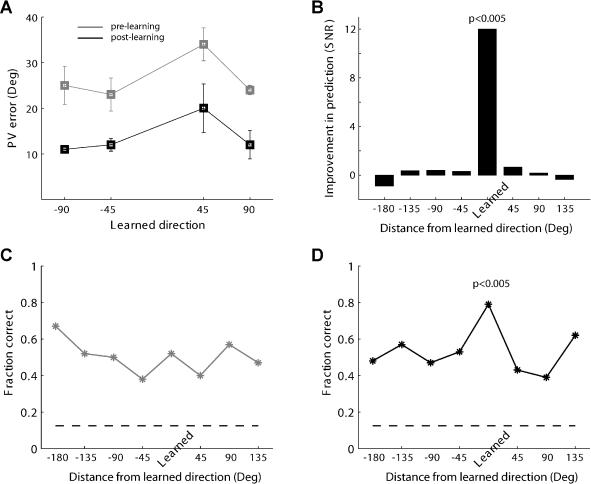
Improved Decoding of Movement Direction Only for the Learned Direction(A and B) Using PV. (A) PV errors given as the distance in degrees between the predicted and the actual direction for the four learned-movement directions (± SEM, bootstrap test). (B) Signal-to-noise ratio (mean/SD) of PV improvement (pre-learning deviation minus post-learning deviation) for all directions (four learned directions are pooled together and all other directions are normalized to them). A significant improvement was observed only for the learned direction (p < 0.005, Bonferoni correction for multiple tests, i.e., the eight directions).(C and D) Using a MAP estimator, we predicted 100 times the actual hand direction using neuronal activity. Shown is the fraction of correct predictions for pre-learning (C) and post-learning (D). A significant increase was observed only for the learned direction (p < 0.005, Bonferoni correction for multiple tests, i.e., the eight directions). The dashed line is the chance level (0.125).